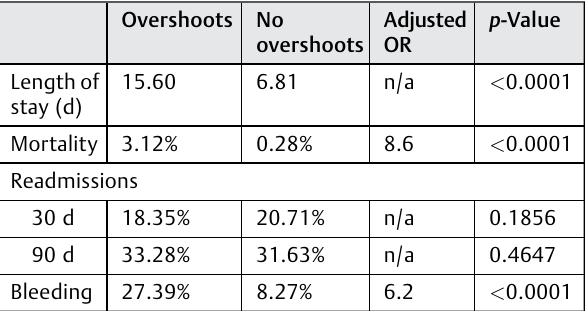
Table 3 Outcomes strati fi ed by INR overshoots